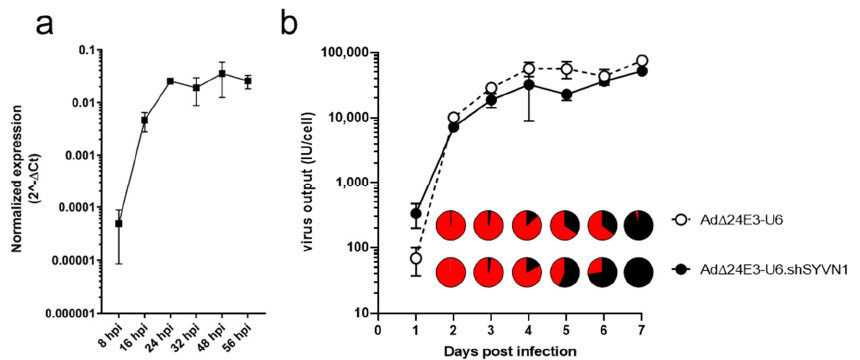
Figure 4. Characterization of oncolytic adenovirus-silencing SYVN1. ( a ) Expression and processing of adenovirus-encoded SYVN1 shRNA in cancer cells. A549 cells were infected with Ad Δ 24E3-U6 or Ad Δ 24E3-U6.shSYVN1 at 100 IU/cell, and total RNA was isolated at the indicated hours after infection. RT-qPCR was done for mature SYVN1 siRNA and for U6 small nuclear RNA as control. SYVN1 siRNA expression was determined using the Δ Ct method. The graph shows mean mature SYVN1 siRNA expression in cells infected with Ad Δ 24E3-U6.shSYVN1 from three independent experiments, each performed in duplicate. SYVN1 siRNA expression was not detected in Ad Δ 24E3-U6-infected cells at any time point. ( b ) Effect of SYVN1 silencing on adenovirus propagation. A549 cells were infected with 10 IU/cell Ad Δ 24E3-U6 or Ad Δ 24E3-U6.shSYVN1. One to 7 days later, virus titers were determined in cells and culture medium separately. Lines show total infectious virus output in cultures infected with Ad Δ 24E3-U6 (broken line, open symbols) or Ad Δ 24E3-U6.shSYVN1 (continuous line, closed symbols). Pie chart inserts show the percentage infectious virus released in the culture medium (black sector) relative to the total amount infectious virus produced, measured at 2–7 days post-infection. Results are the means of an experiment performed in triplicate. Differences between the two viruses are not significant, except for total virus production on day 1 ( p = 0.03, two-tailed t -test).